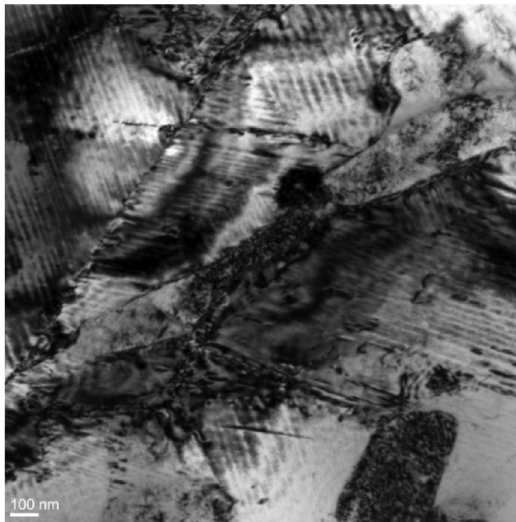
Figure 5: Micrograph showing grain boundary dislocation generation in Ti555211 alloy deformed at 950°C and 1 s − 1 to a true strain of